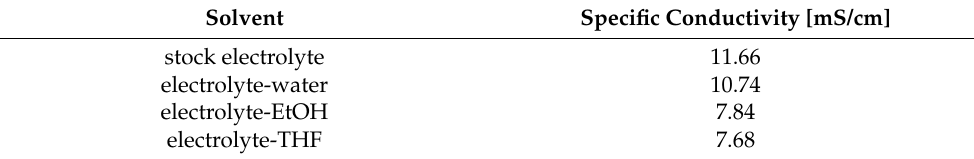
Table 2. Specific electrical conductivities of the solutions used in the experiments, determined at 25 °C. Stock electrolyte was a 0.0943 mol/dm 3 aqueous solution of Li 2 CO 3 , and the mixtures with water, ethanol, and THF were prepared at volume ratios of 9:1. The conductivity of the water used to prepare the solutions was less than 1 µ S/cm.